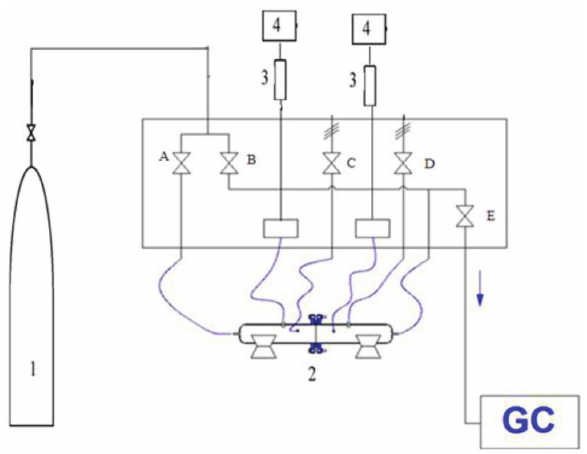
Fig. 1 – Experimental set-up for measuring permeability of SILMs (1: gas bottle, 2: Membrane test chamber, 3 and 4: P = pressure gauges; A, B, C, and D are gas